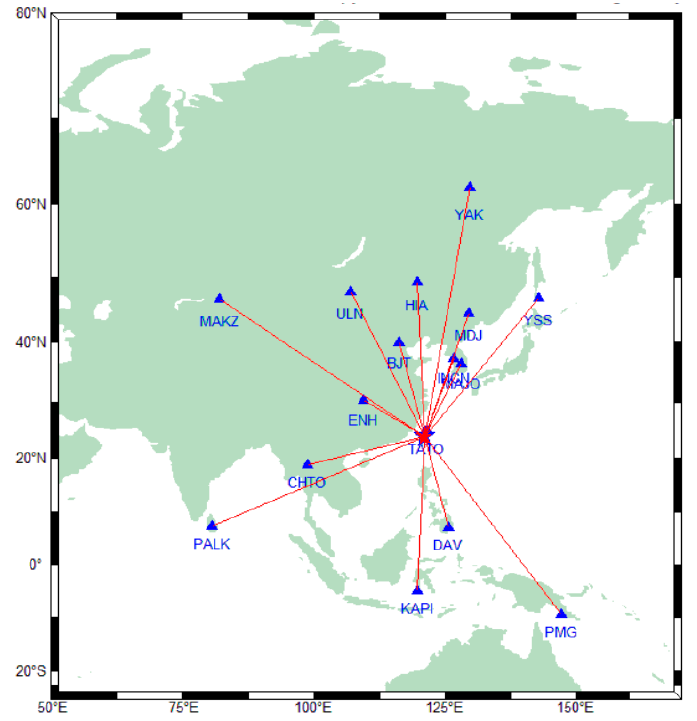
Figure 1. Locations of the epicenter (star) of the Meinong earthquake and 16 teleseismic stations (triangles) used for assessing the STFs of the event (M w = 6.4).